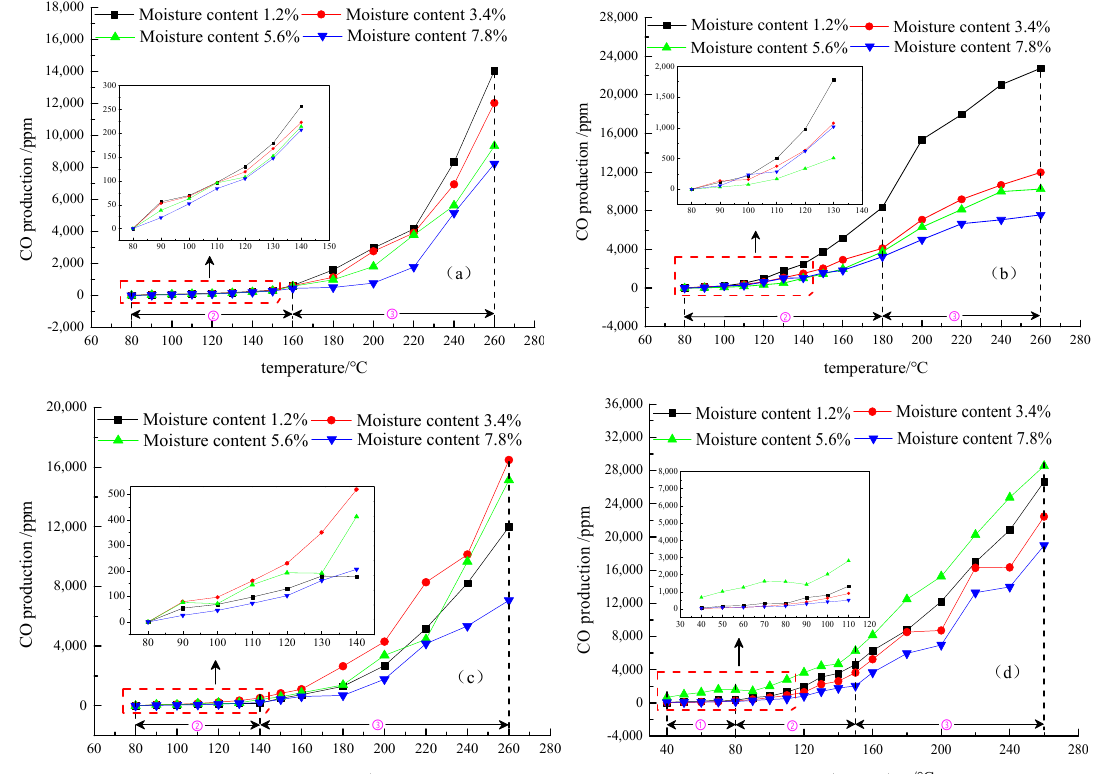
Figure 5. The curves of CO production for anthracite ( a ), fat coal ( b ), long flame coal ( c ), and lignite ( d ) at four different low moisture content. ① indicates the slow oxidation stage, ② indicates the rapid oxidation stage, and ③ indicates the violent oxidation stage.